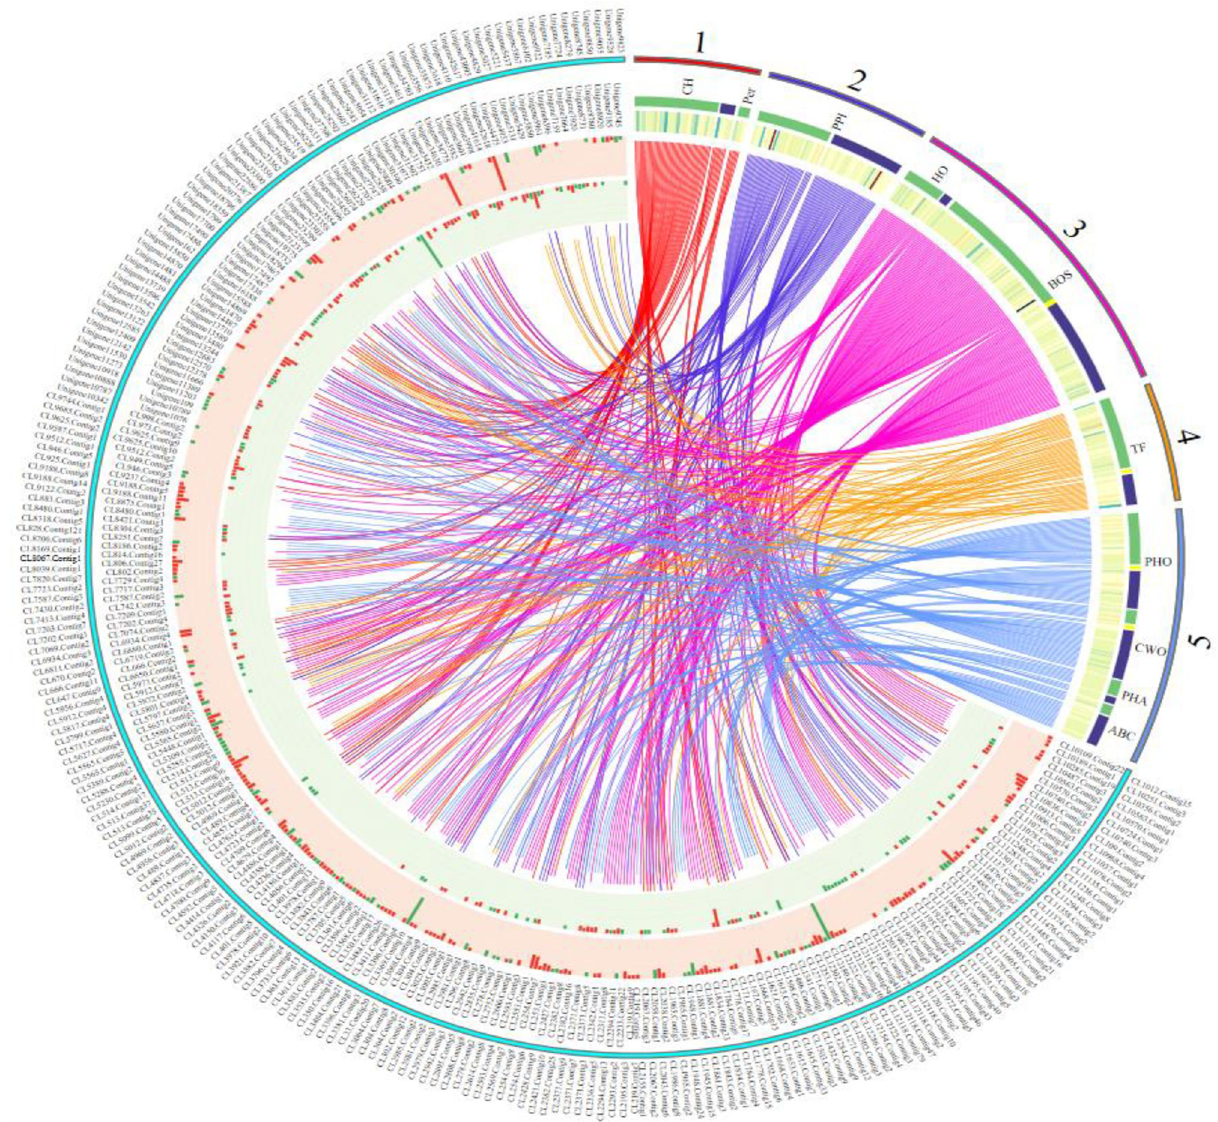
Fig 5. Circular map of crucial genes in response to Leifsonia xyli subsp. xyli . The inside and outside of the cyan coils represent the gene IDs of DEGs; the corresponding middle circle and the innermost circle represent the gene expression in leaves and stems respectively; the red one represents the up- regulation, and the green one represents the down-regulation. The numbers 1, 2, 3, 4, 5 represent photosynthesis, plant disease interactions, hormone and secondary metabolism, transcription factors, and other genes (genes related phosphorylated, cell walls and ABC transports), respectively. The corresponding green and blue colors represent leaves and stems,